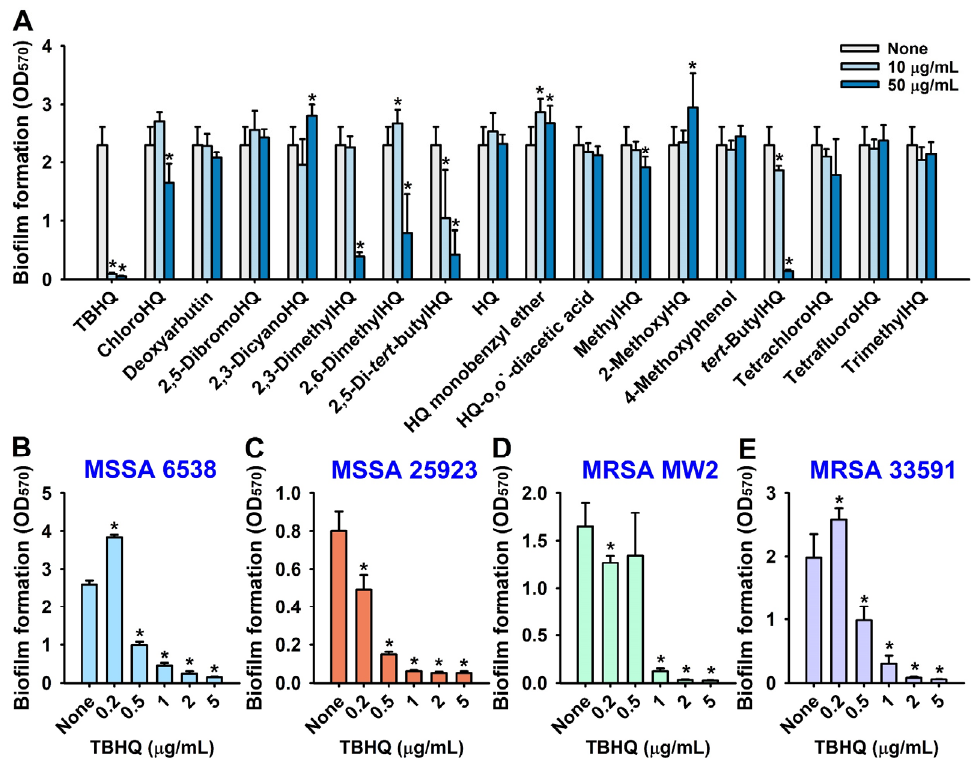
Figure 1. Inhibition of S. aureus biofilm formation by hydroquinones. The antibiofilm activities of HQ and its derivatives on MSSA 6538 were investigated in 96-well polystyrene plates after culture for 24 h ( A ). The antibiofilm activities of TBHQ were investigated against MSSA 6538 ( B ) and MSSA 25923 ( C ), MRSA MW2 ( D ), and MRSA 33591 ( E ) after culture for 24 h. * p < 0.05 vs. non-treated controls